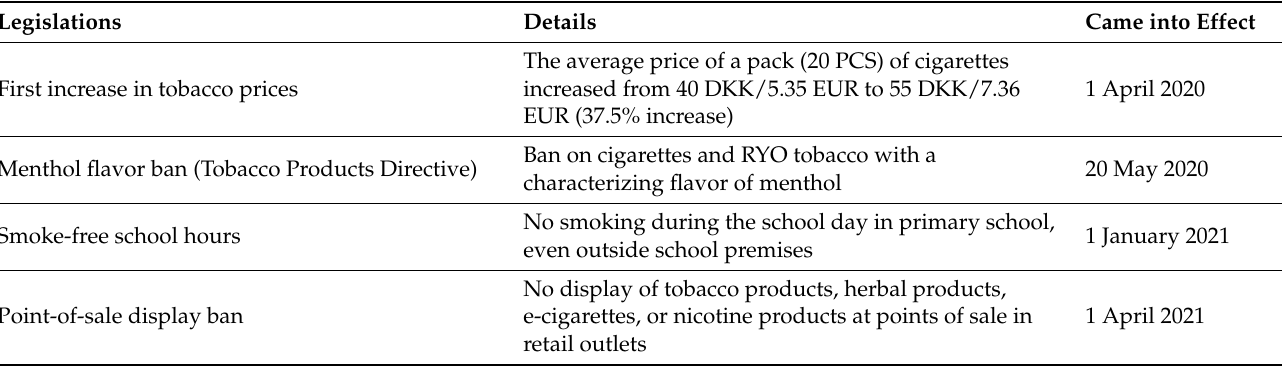
Table 1. Overview of the most important legislations implemented from